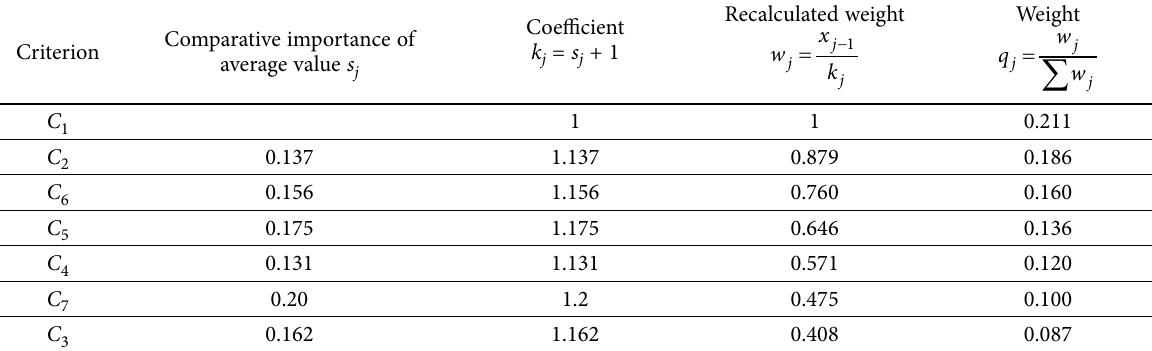
Table 7. Final results of SWARA method in weighting criteria Comparative importance of Criterion average value s